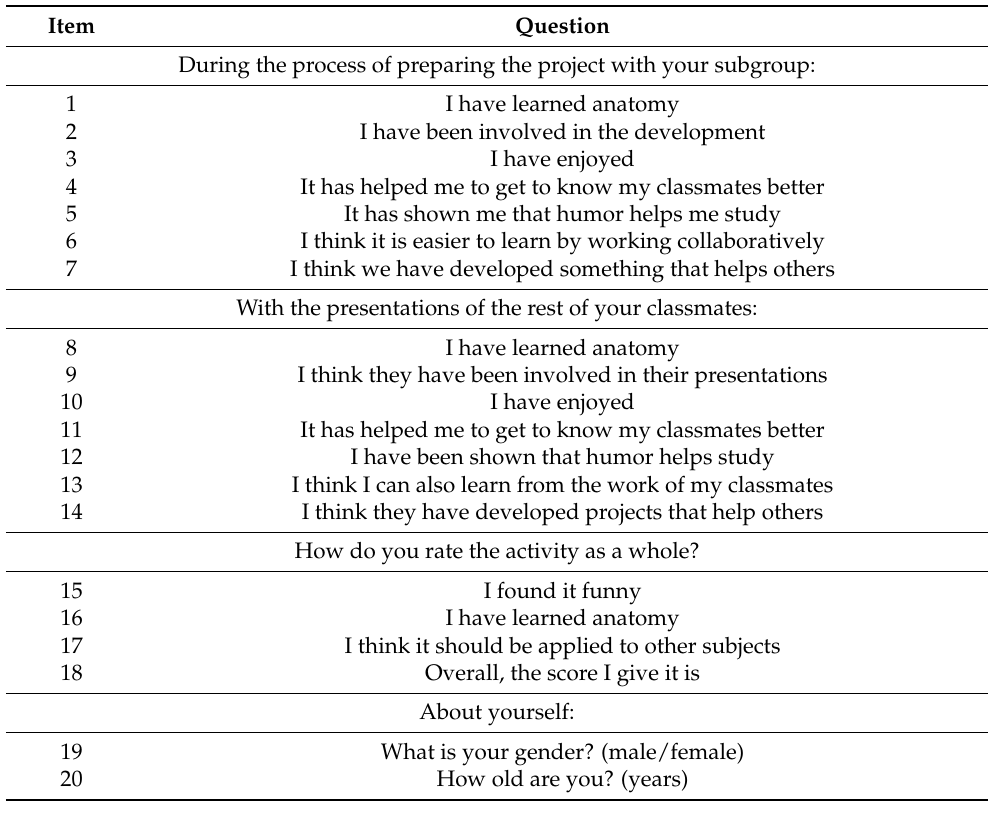
Table 1. Survey technology-based project in